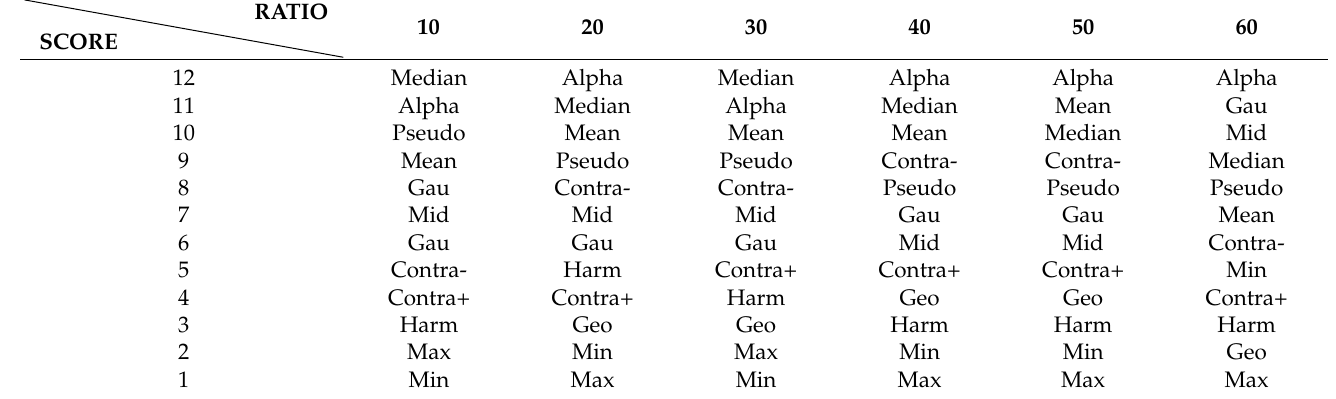
Table 7. Evaluation of Spatial and Adaptive Filters for Impulsive Noise.